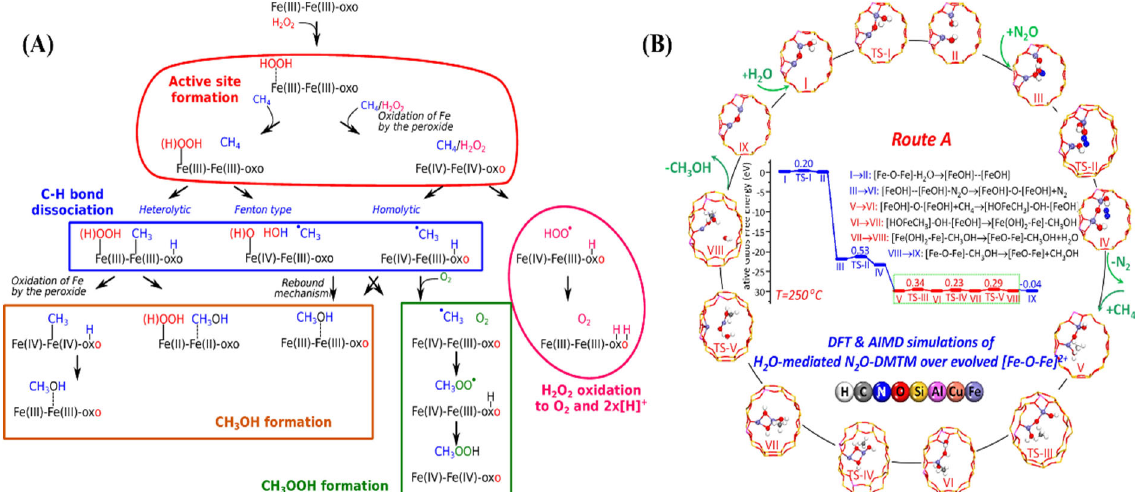
Figure 3. ( A ) Schematic representation of the reaction network and most important steps underlying the oxidation of methane with H 2 O 2 over Fe/ZSM-5 zeolite. Reprinted/adapted with permission from Ref. [78]. Copyright 2018, copyright American Chemical Society, and ( B ) DFT [(I → IV) and (VIII → IX)] and AIMD (V → VIII, green dash line) simulation results of H 2 O–mediated N 2 O–DMTM over the binuclear Fe site; insert is Gibbs free energy diagram ( T = 250 °C). Reprinted/adapted with permission from Ref. [108]. Copyright 2022, copyright Elsevier Ltd.